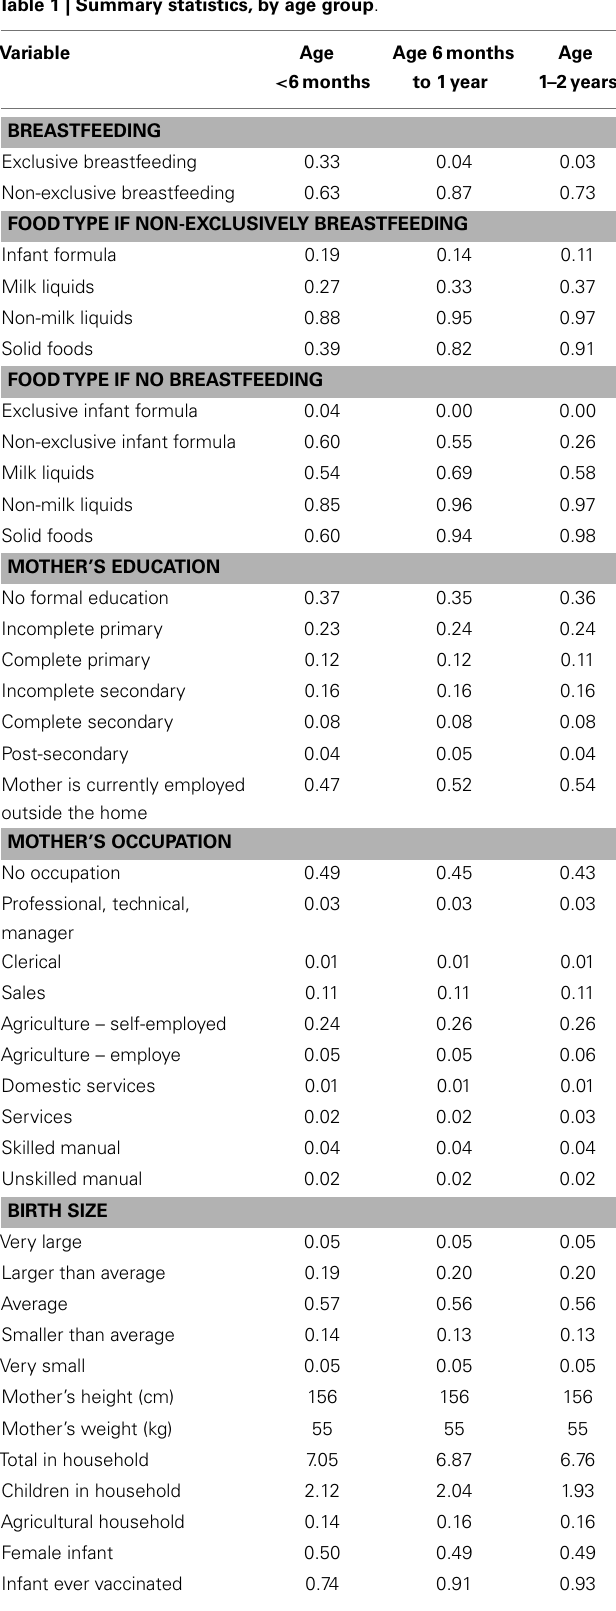
Table 1 | Summary statistics, by age group